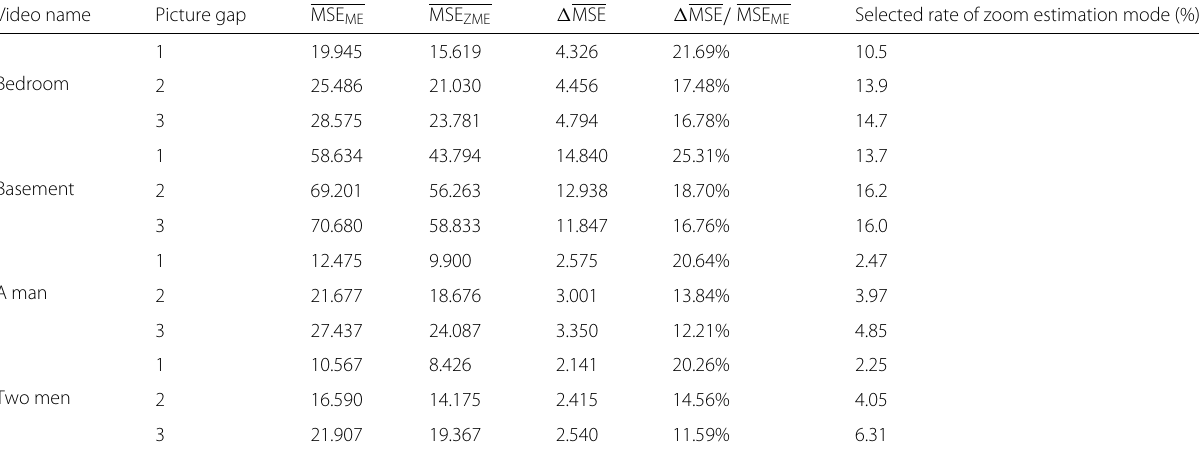
Table 2 Averages of MSEs in color video according to frame gap in 16 × 16 block